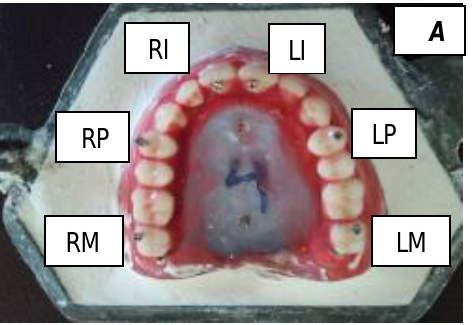
Figure 3, A: the reference points for teeth movements.